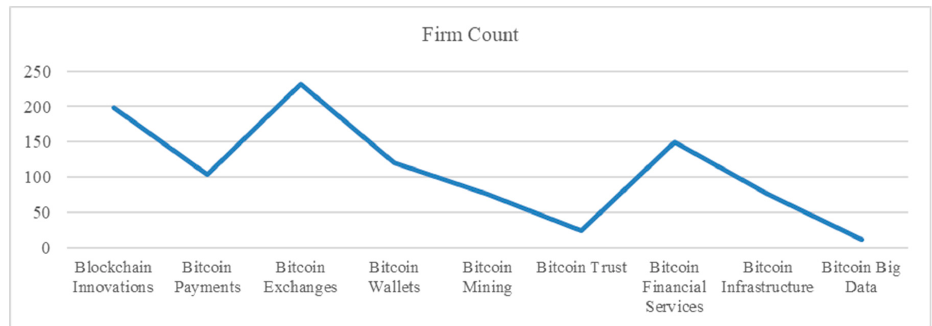
Figure 10. Number of blockchain technology deals by different categories. Source: CB insights, PwC, ICO Insights and Token Data.